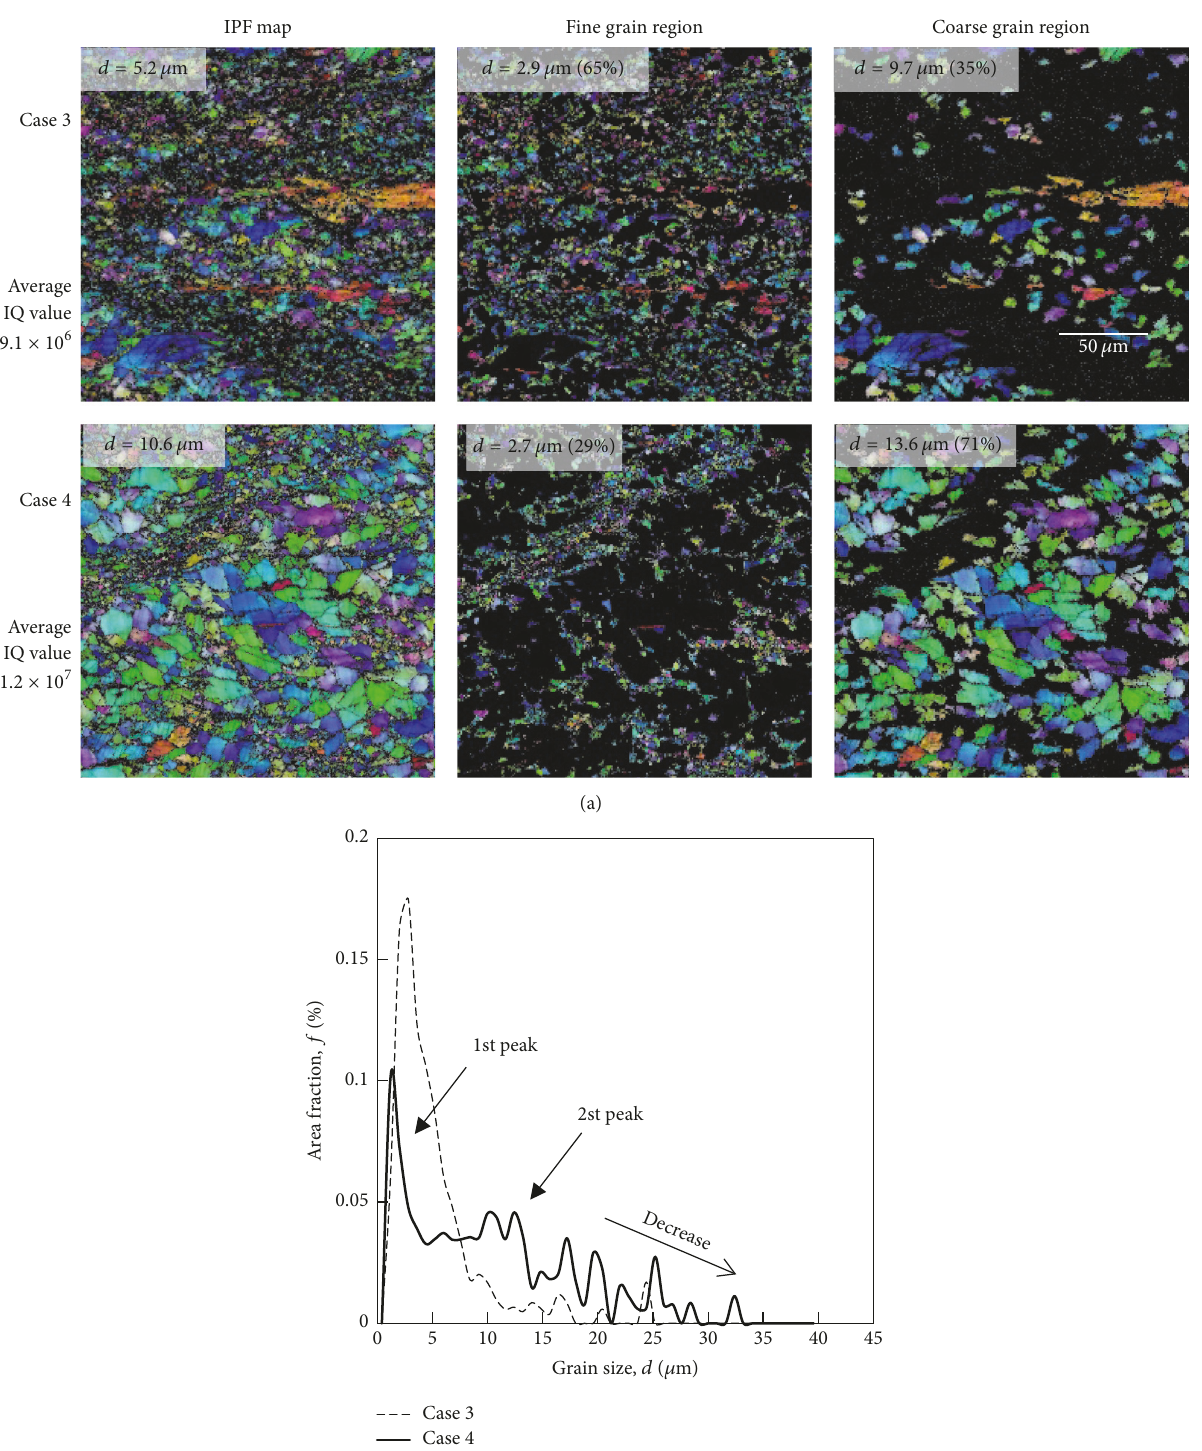
Figure 7: (a) Inverse pole figure maps of the 3 mm thick rolled sample and (b) the grain size distribution diagram. The grain size and area fraction are shown in the IPF